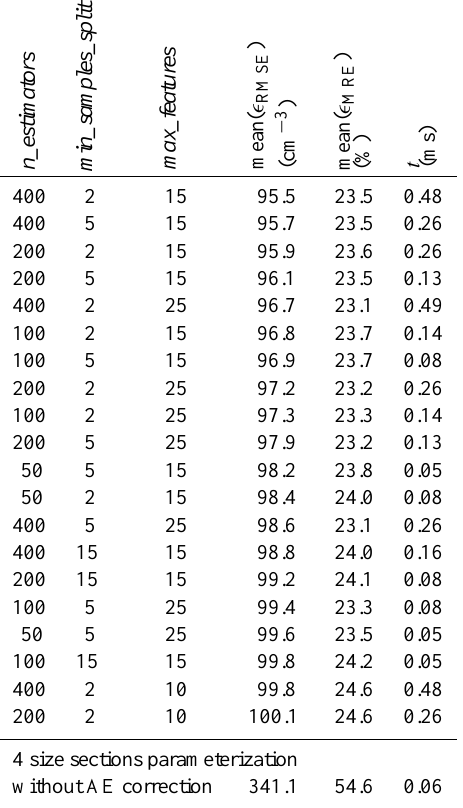
The mean of the CDNC values computed with the 70 size sections parameterization: 574.8 cm − 3 . The standard deviation of the CDNC values computed with the 70 size sections parameterization: 509.5 cm − 3 .